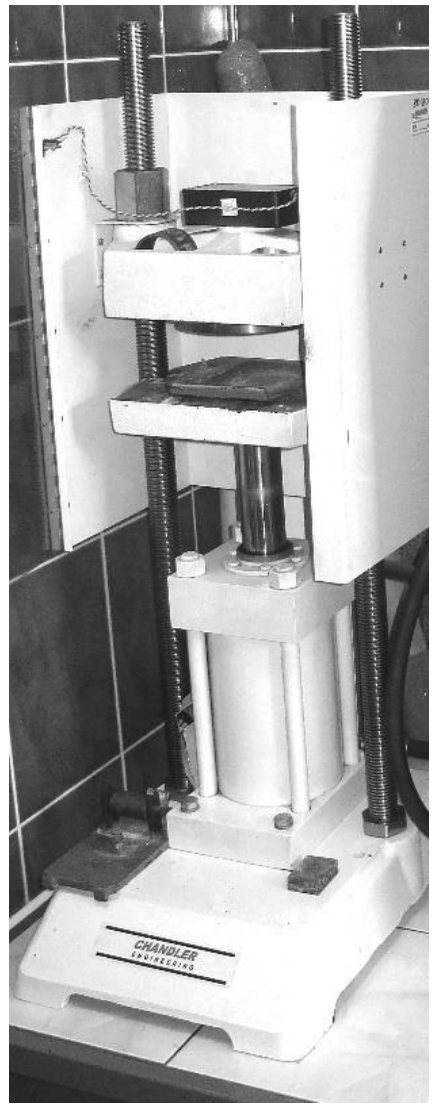
Figure 5. Machine for testing strength and adhesion. The contact force ( P ) was read from the testing machine. The contact surface of the rock with the hardened cement slurry was equal to the value of the outer surface area of the core and the height of the cement slurry in the mold. Figure 6 shows the dimensions necessary to determine the contact surface of the rock with the hardened cement slurry. In order to obtain reliable results, all tests were carried out using a cement slurry of the same composition. The results of the adhesion tests obtained on the contact between the hardened cement slurry and the rock core are presented in Table